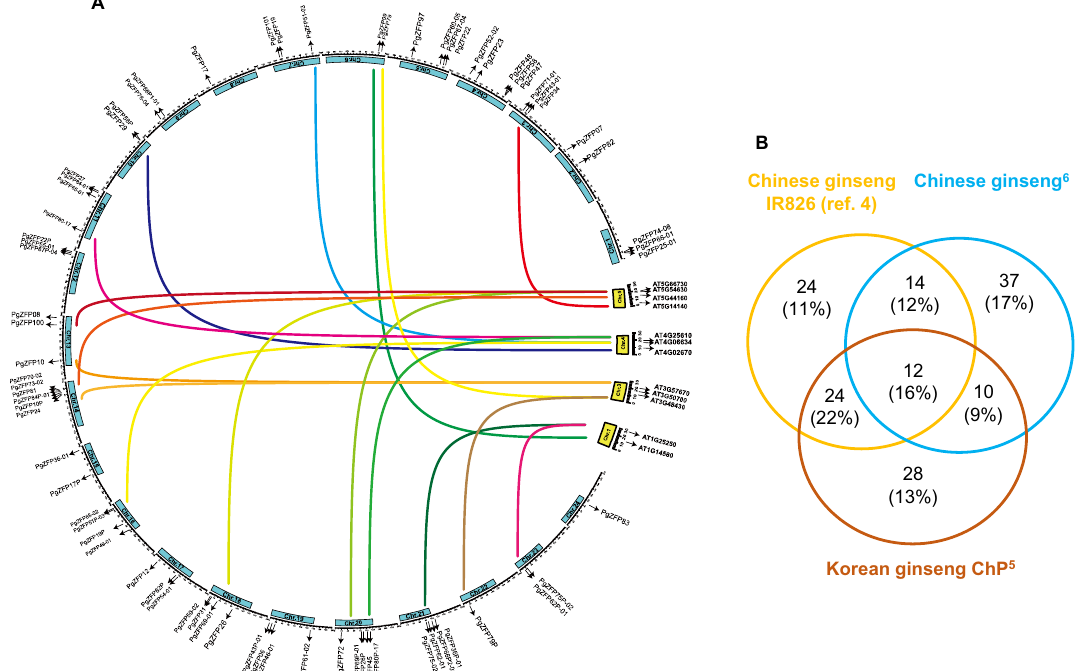
Figure 1. The distribution of the PgZFP gene family in the ginseng genome and its family size variation among ginseng genotypes. ( A ) The positions of the PgZFP gene family in the Chinese ginseng genome 6 and its synteny with the Arabidopsis genome. The PgZFP genes were mapped to all 24 ginseng chromosomes indicated by light blue bars and their Arabidopsis orthologues were mapped to four of the five Arabidopsis chromosomes indicated by yellow bars. ( B ) Venn diagram showing the pan- and core-transcriptomes of the PgZFP gene family. The numbers in the Venn diagram indicate the numbers of the PgZFP genes in the family that are genotype- specific, shared between the genotypes, and common among all three genotypes. The percentage of the genes was calculated by the numbers of genes divided by the total number of the PgZFP genes (221) aligned to the genome of each genotype times